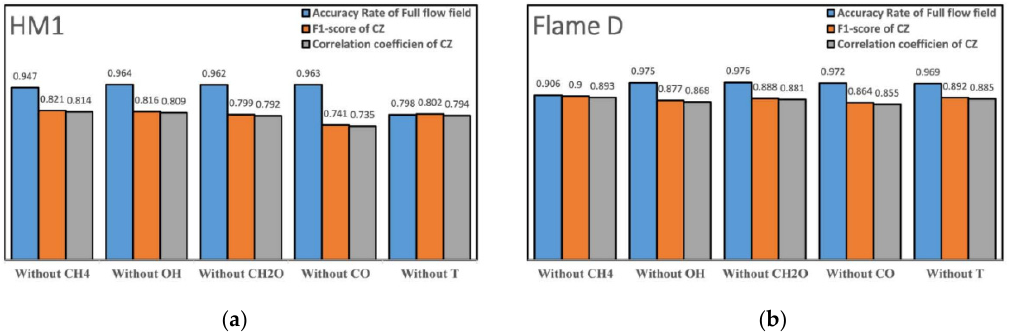
Figure 10. Identification accuracies with four-dimensional BPNN: ( a ) HM1; ( b ) Sandia Flame D.